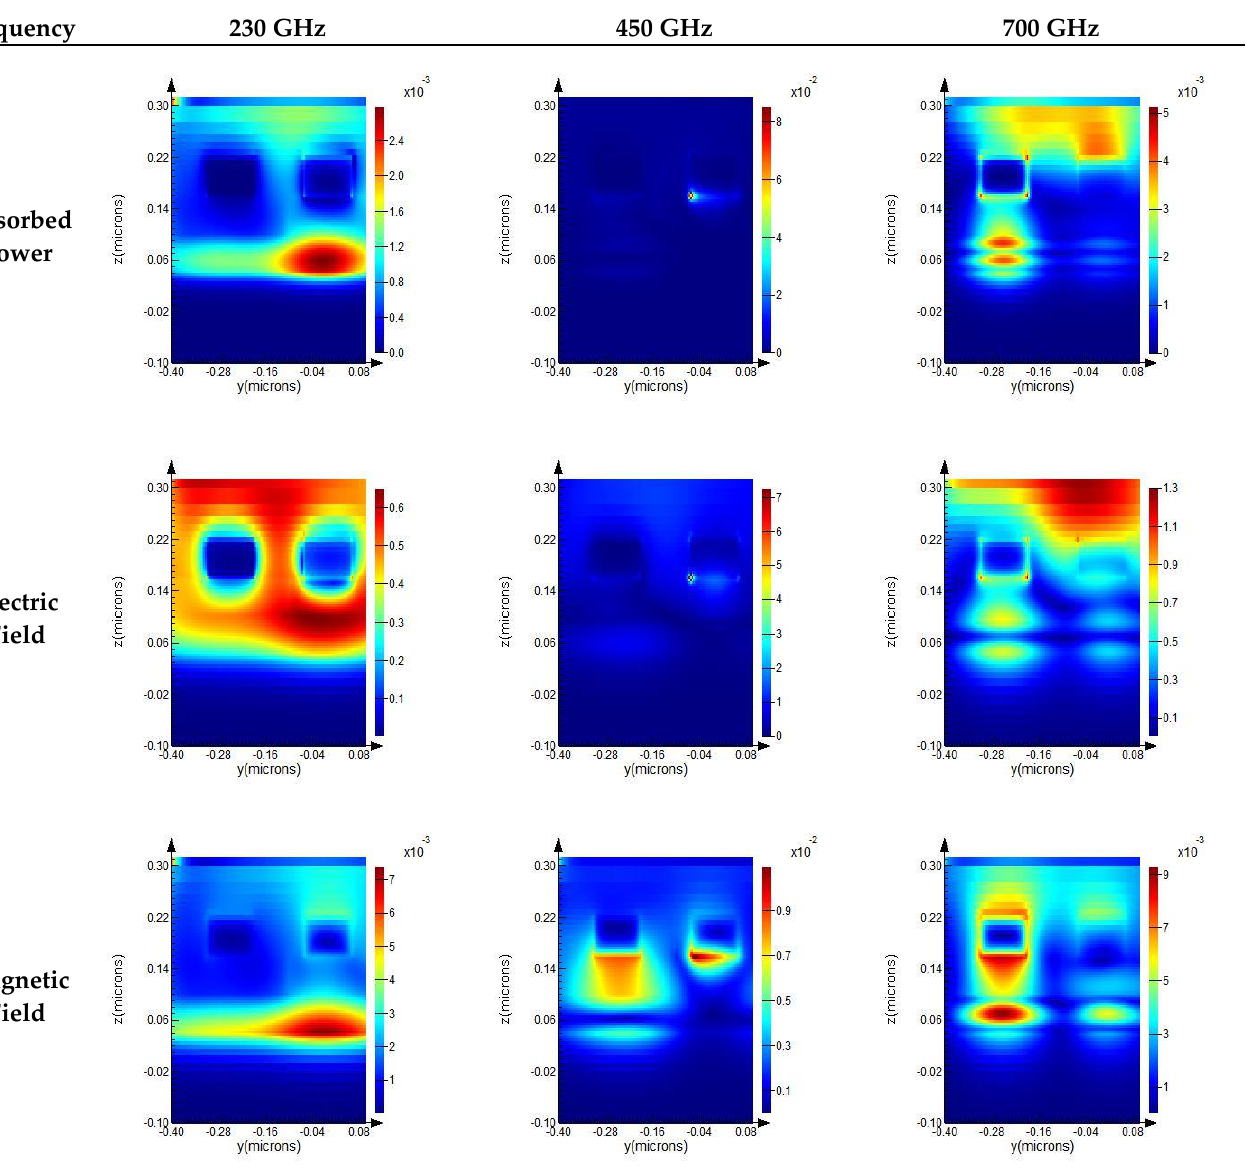
Figure 13. Absorbed optical power, electric field distribution, and magnetic field distribution in the proposed MMA structure at different frequencies.